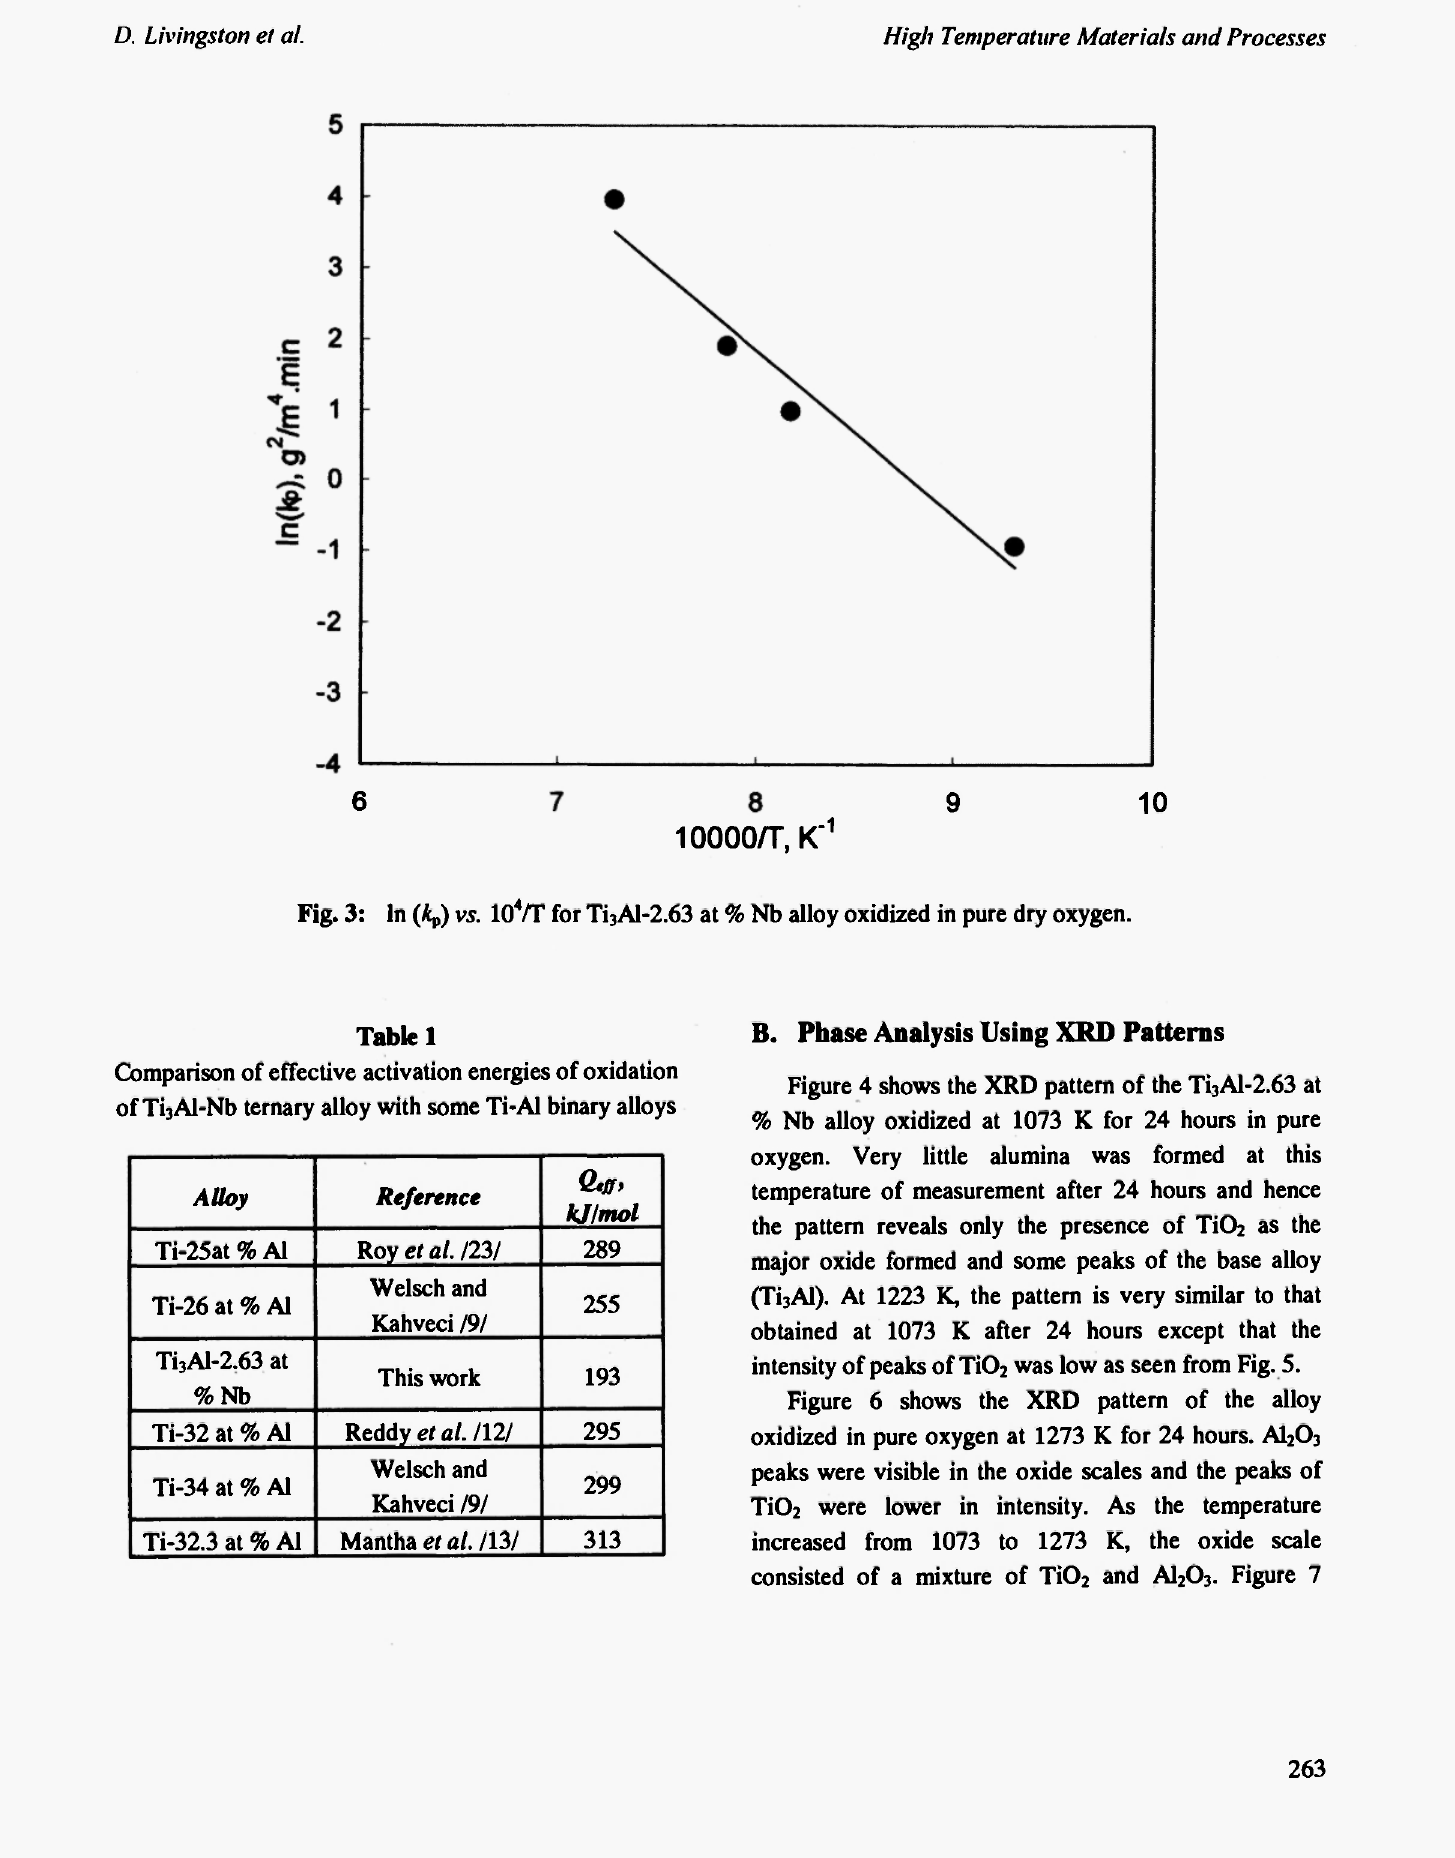
Fig. 3: In (Äp) vs. 10 4 /T for Ti